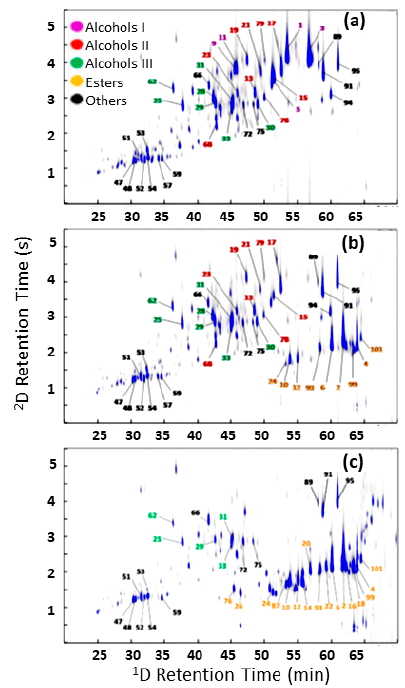
Figure 5. GC × GC-mass spectrometry chromatograms of ( a ) the natural Haitian vetiver essential oil, ( b ) the enzymatically acetylated oil, and ( c ) chemically transformed into vetiveryl acetate. The compound identity can be consulted in the source literature: adapted with permission from Francesco et al. [101].